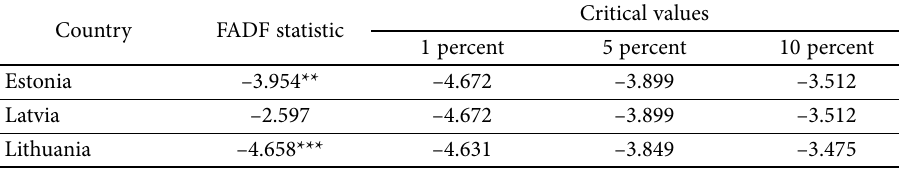
Table 3(c). Nonlinear FADF test results (FADF statistic) Critical values Country FADF statistic 1 percent 5 percent 10 percent –3.954** –4.672 –3.899 –3.512 –2.597 –4.672 –3.899 –3.512 –4.658*** –4.631 –3.849